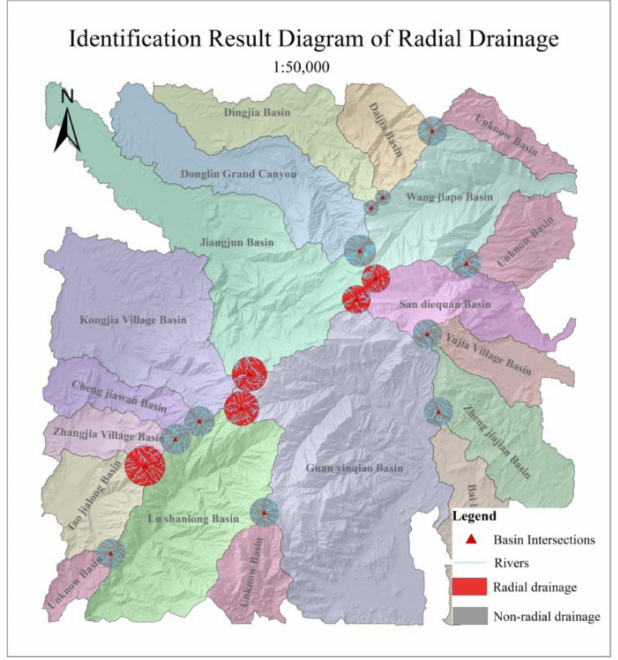
Figure 15. The identification result of drainage patterns without removing non-radial river